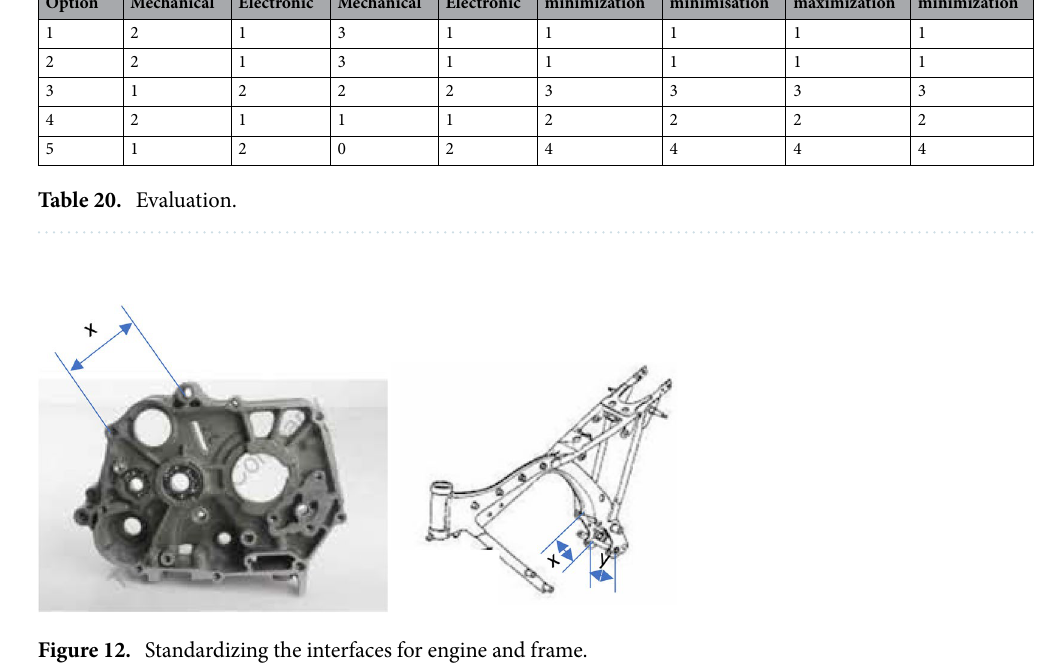
Figure 12. Standardizing the interfaces for engine and